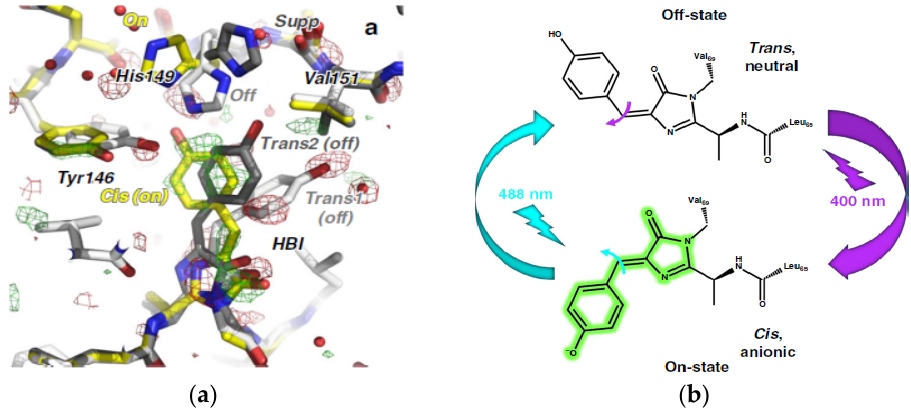
Figure 13. ( a ) The on and off states of the rsEGFP2 protein chromophores. ( b ) The 10-ns intermediate structure; the photodifference map shows the chromophore ligand time-evolution (note the negative peaks indicate the trans1 configuration depletion, whereas the positive green contours indicate the formation of new intermediate trans2 form and the final cis form). Figure reproduced with permission from Woodhouse et al. [124]. Copyright (2020) Springer Nature.